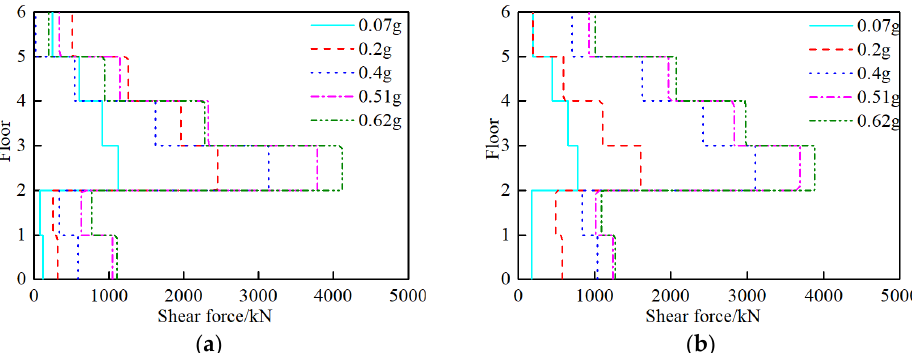
Figure 5. Distribution of story shear at the moment of maximum base shear: ( a ) Along the slope direction; ( b ) Across the slope direction.